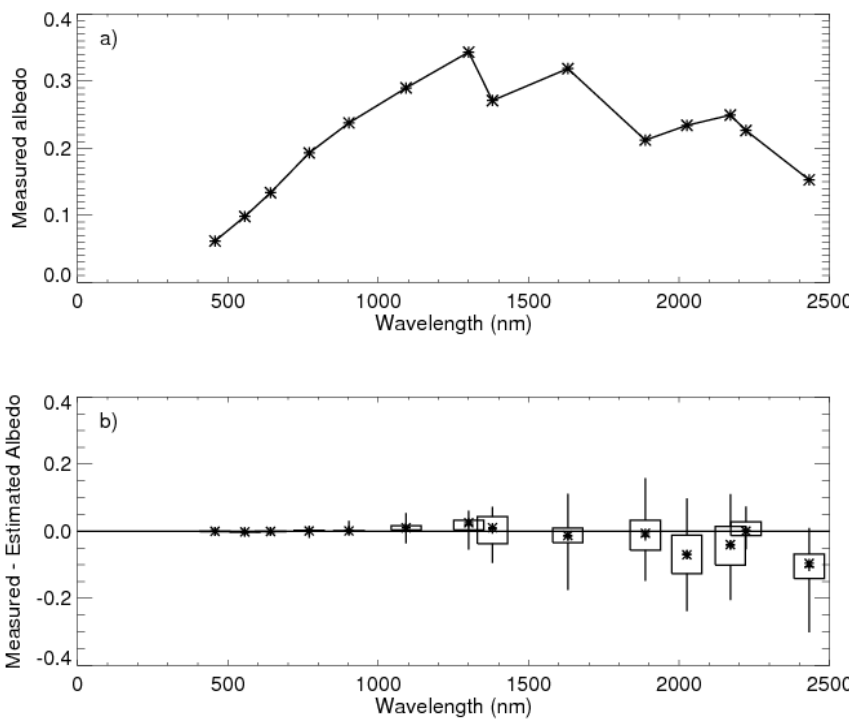
Fig. 6. Evaluation of methodology for all non-vegetated cases during IOP. (a) Average measured albedo within each spectral region and (b) box-whisker diagram showing differences between measured and estimated albedo in each spectral region.